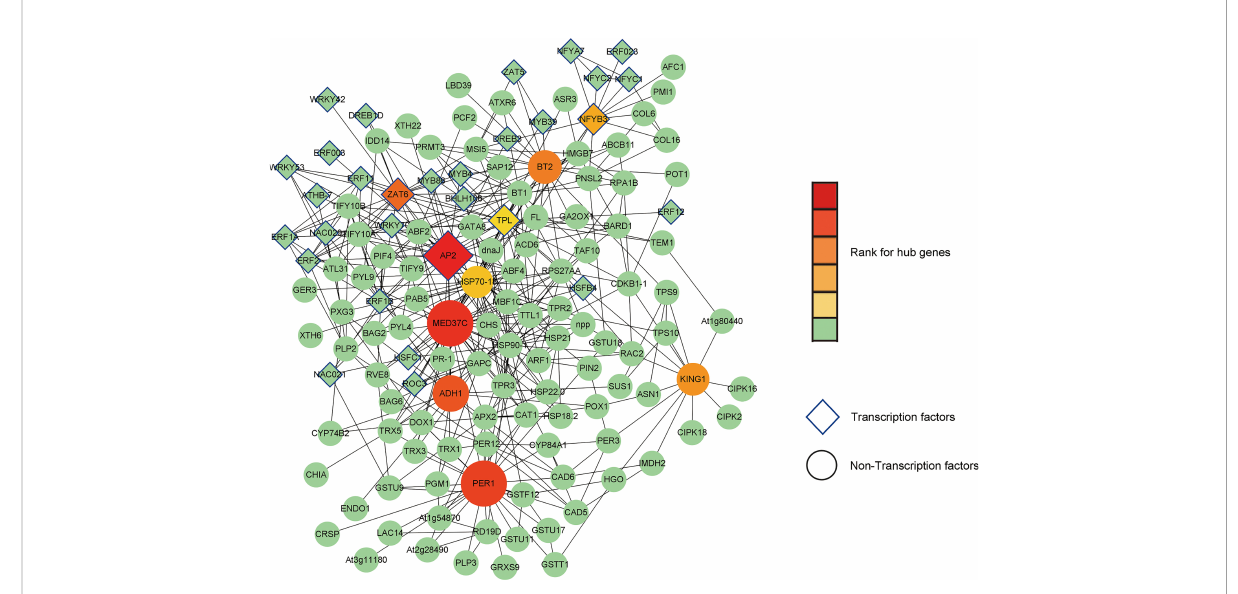
FIGURE 12 Ten putative hub genes and their interacting proteins. Transcription factors and non-Transcription factors are shaped as diamond and ellipse, respectively. Larger size and darker red color represent higher rank, while green color annotates lower rank.